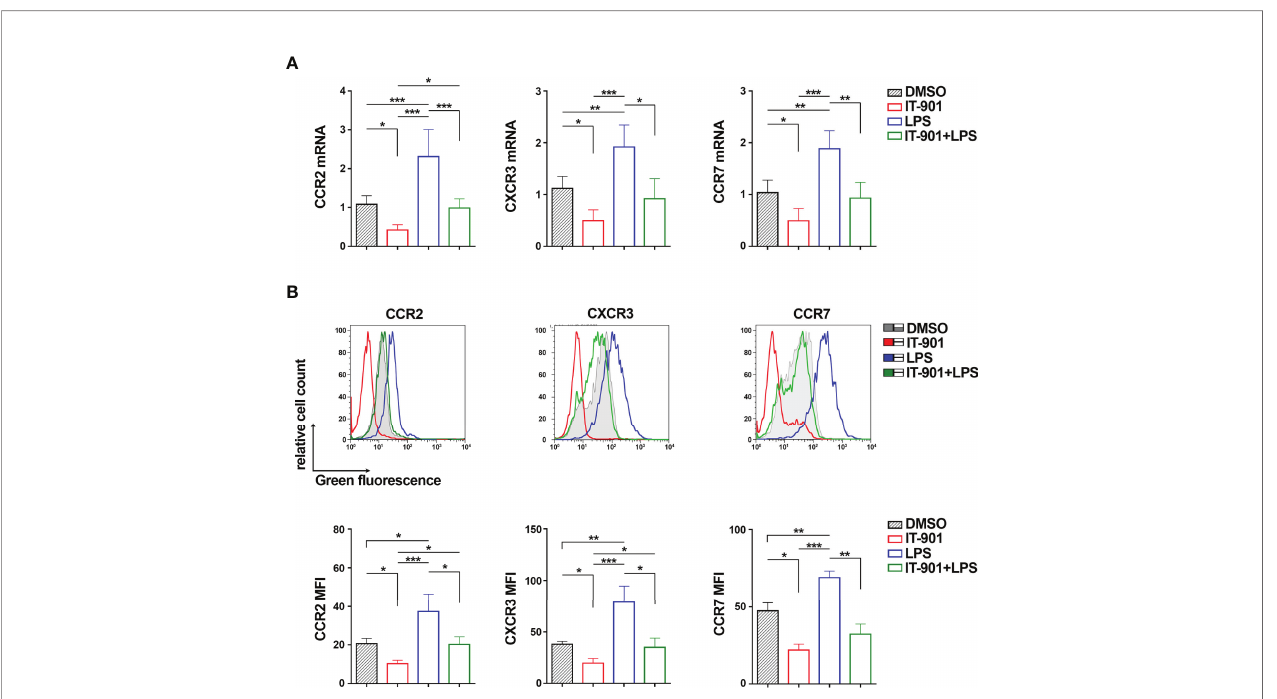
promoter to amplify DNA regions containing the putative p65 binding sites with the highest binding scores ( Table 1 ) (a detailed list of the sequences ampli fi ed by qRT-PCR is shown in Supplementary Table 4 ). P65 binding was evaluated by ChIP